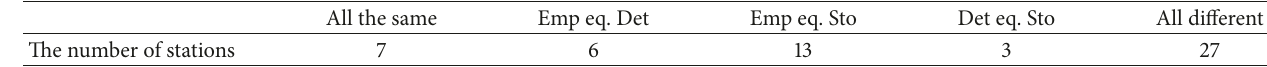
Table 3: Differences and indiscrimination of results from the three methods.